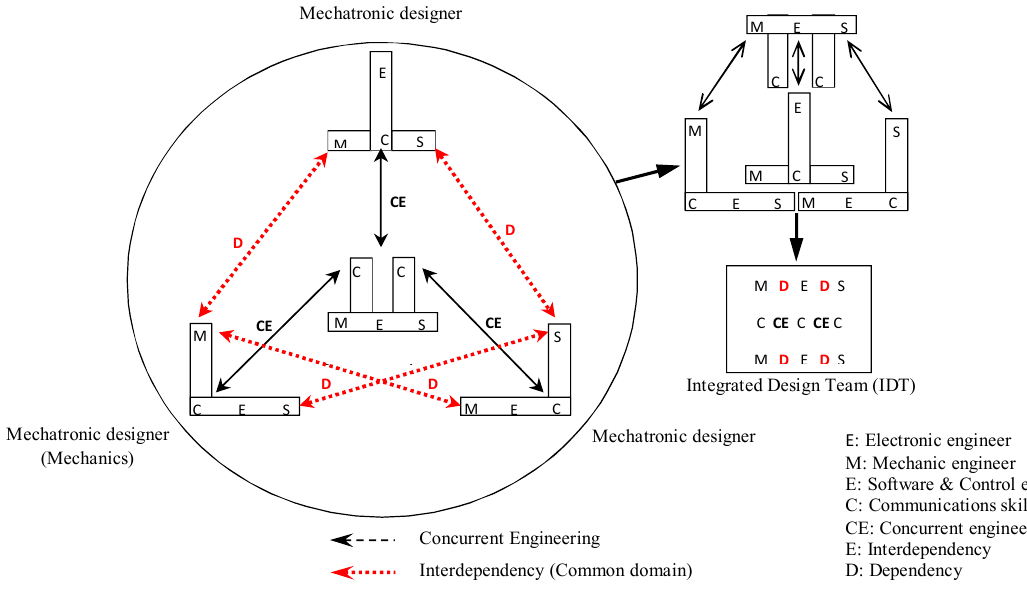
Fig. 7 . Structure of integrated team and required knowledge fields for mechatronic